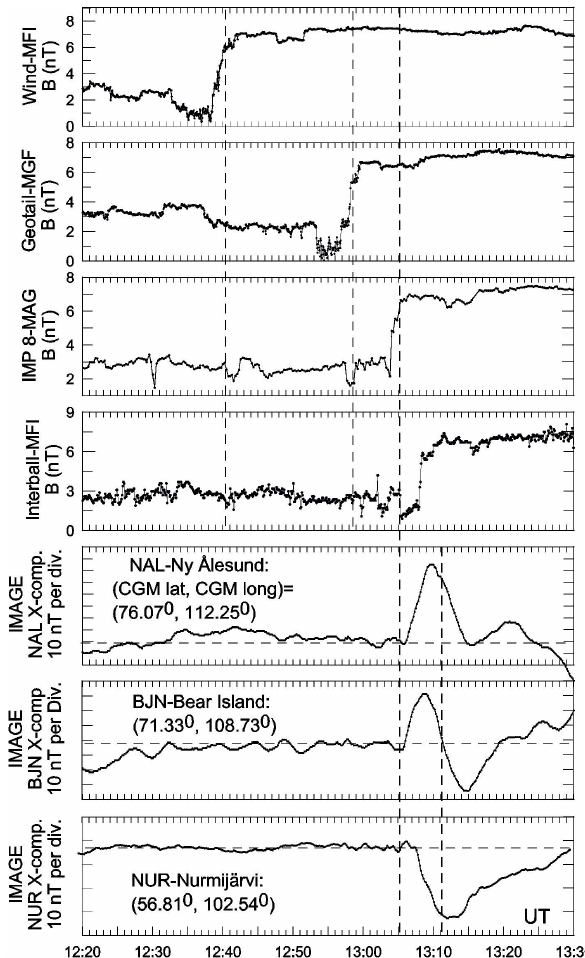
Fig. 11. Abrupt increases identified along the magnetic field strength traces of Wind, Geotail, IMP-8 and Interball are caused by the solar wind pressure drop that occurred on 7 August 1997. The discontinuity gives rise to monopolar positive (negative) excursion at NAL (NUR) station, and bipolar PN-type feature at